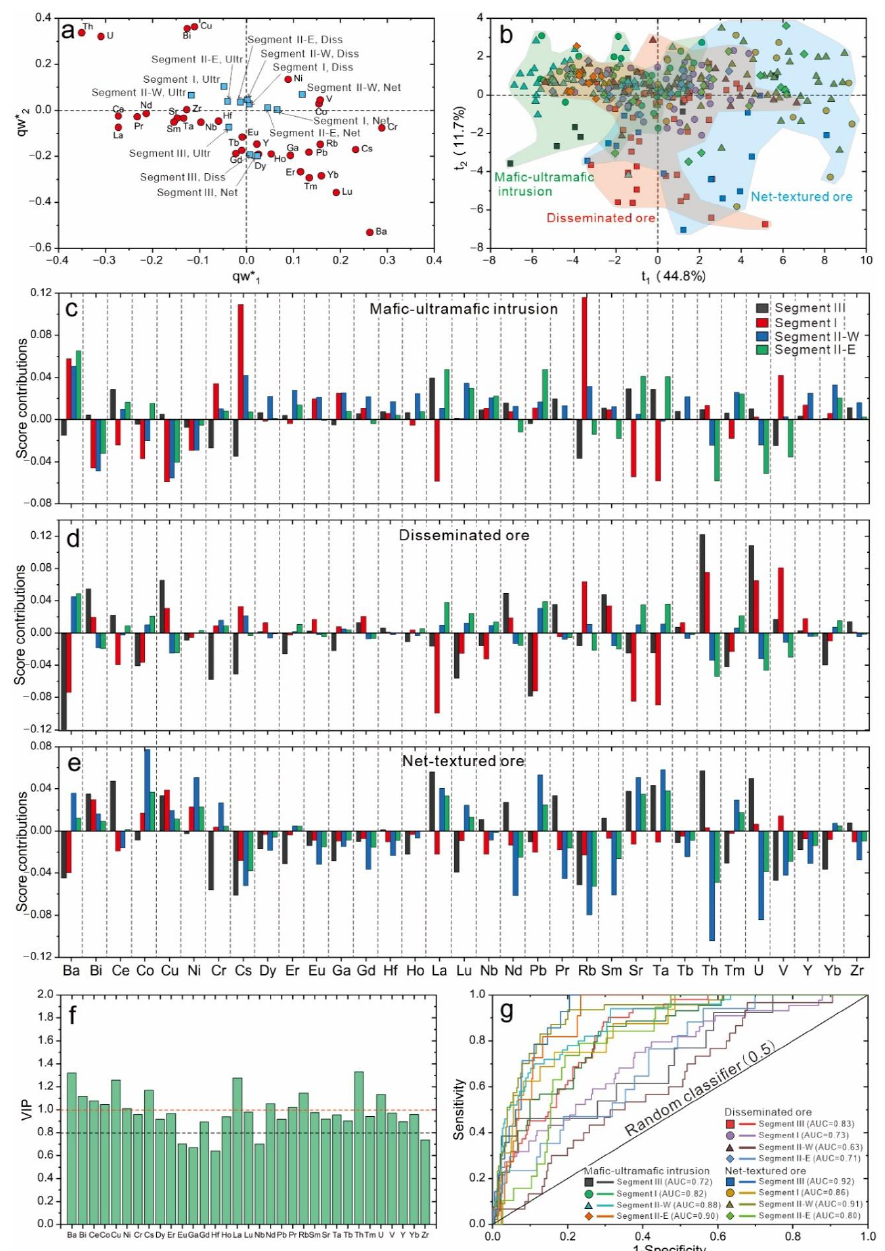
Figure 11. PLS-DA of whole-rock trace element data for different ore types in each segment of the Jinchuan deposit. ( a ) The qw* 1 –qw* 2 loading plots; ( b ) The t 1 –t 2 score plots. The score contributions plots for ( c ) mafic–ultramafic intrusions, ( d ) disseminated ores, and ( e ) net-textured ores. ( f ) The VIP plots and ( g ) ROC curve.